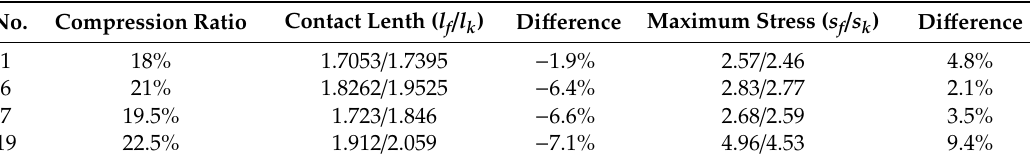
Table 4. Comparison of analysis model and Karaszkiewicz model.